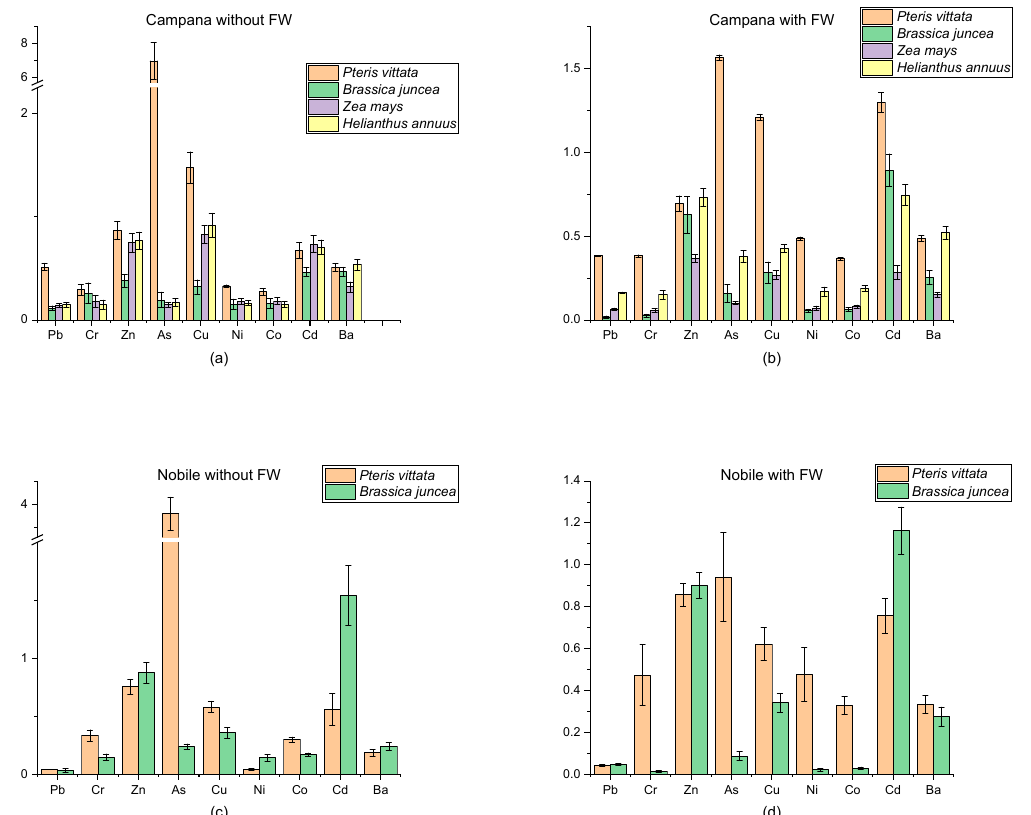
Figure 3. Bioconcentration factors (BFs) of plants chosen for phytoremediation and grown in ( a ) Campana without FW, ( b ) Campana with FW, ( c ) Nobile without FW and ( d ) Nobile with FW. Values are expressed as mean ± SD.